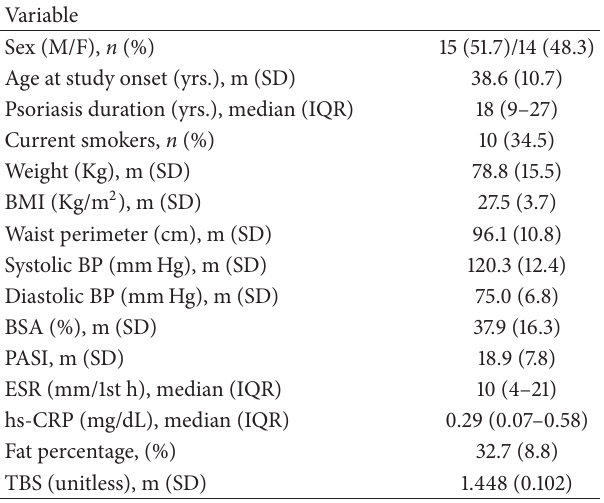
Table 1: Main baseline epidemiological characteristics of the patients.